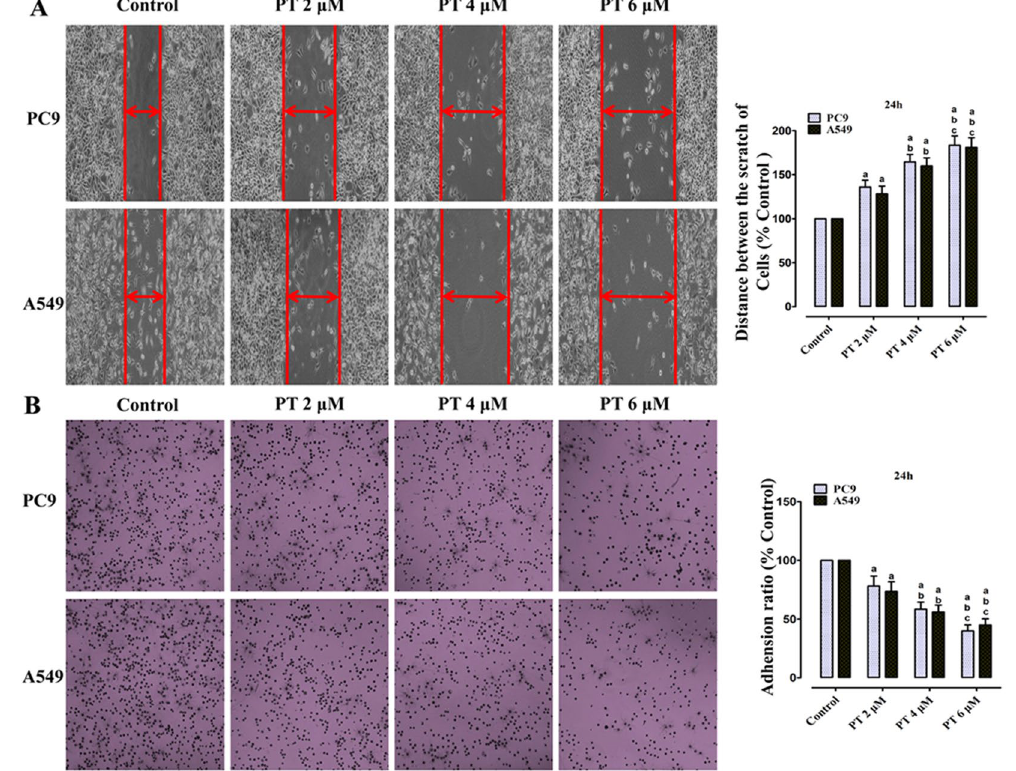
Figure 4. Effect of PT treatment on the abilities of migration and adhesion in PC9 and A549 cells (24 h). ( A ) Representative wound healing images of each cells were shown, and the migratory ability is expressed as the mean distance between the two sides of the scratch. The mean distance in the control group was set as 100%. ( B ) Representative adhesion images of each cell lines were shown, and the adhesion ability of cells is expressed as an adhesion ratio. The number of adherent cells in the control group was set as 100%. All of the results were expressed as the mean ± SD; n = 6. a P < 0.05 vs . the control group, b P < 0.05 vs . the 2 μ M PT-treated group, c P < 0.05 vs . the 4 μ M PT-treated